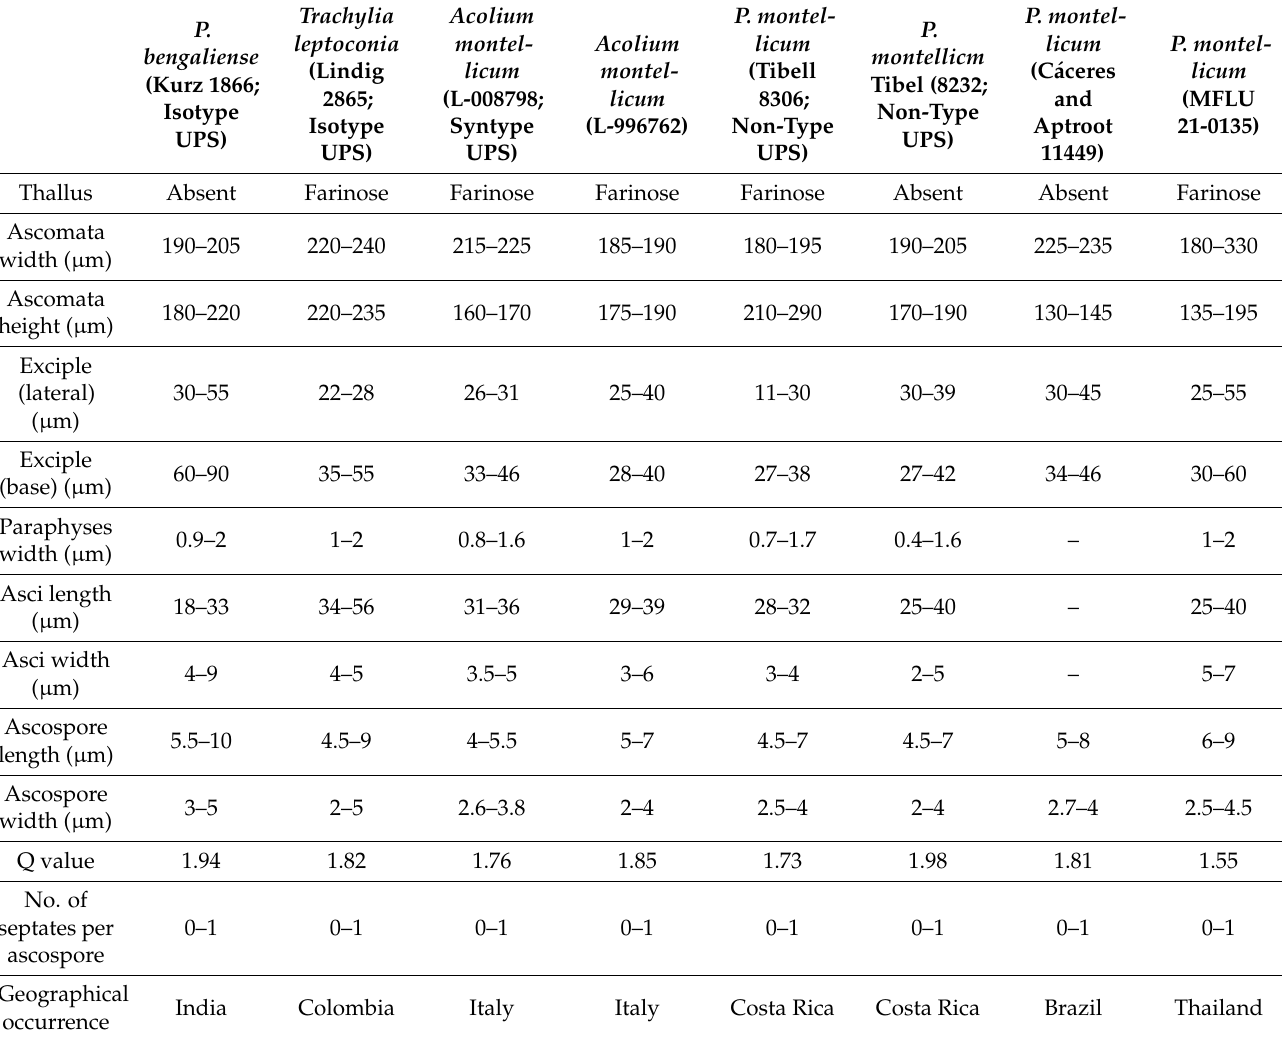
Table 3. Morphological comparison of the herbarium and fresh specimens based on this